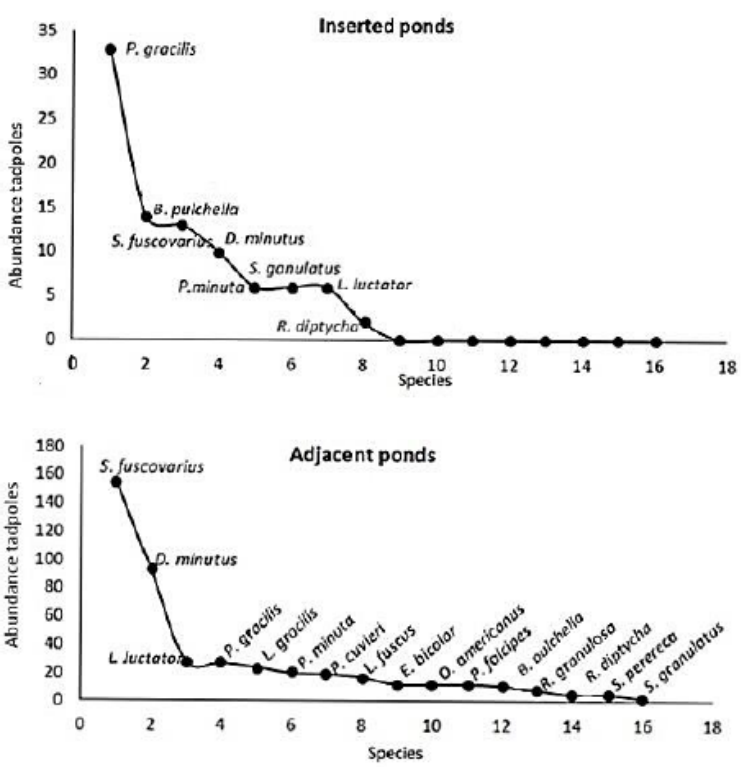
Figure 3. Species ranking of tadpoles collected in ponds inserted in and adjacent to soybean